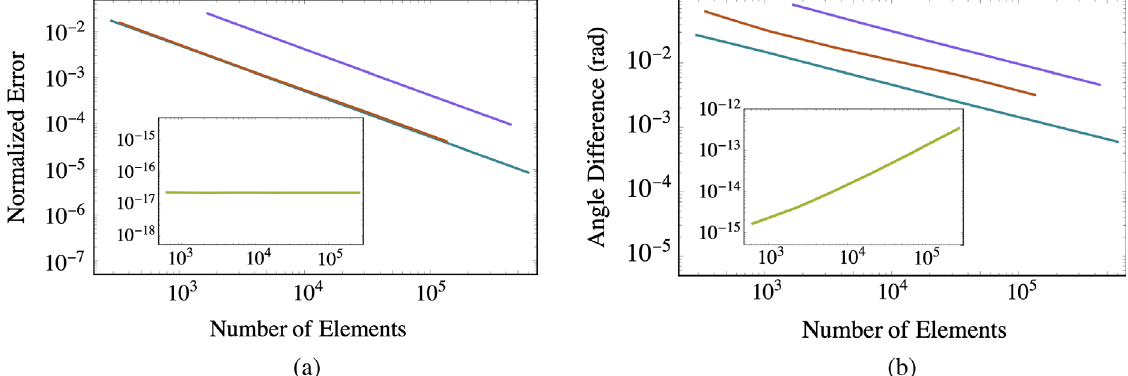
FIG. 2. Plotted is the normalized deviation of the surface nodes from the physical surface (a) and the deviation of normal vector angle (b). Results for the sphere (blue line), cylinder (orange line), rectangular prism (green line), and ellipsoid (purple line).